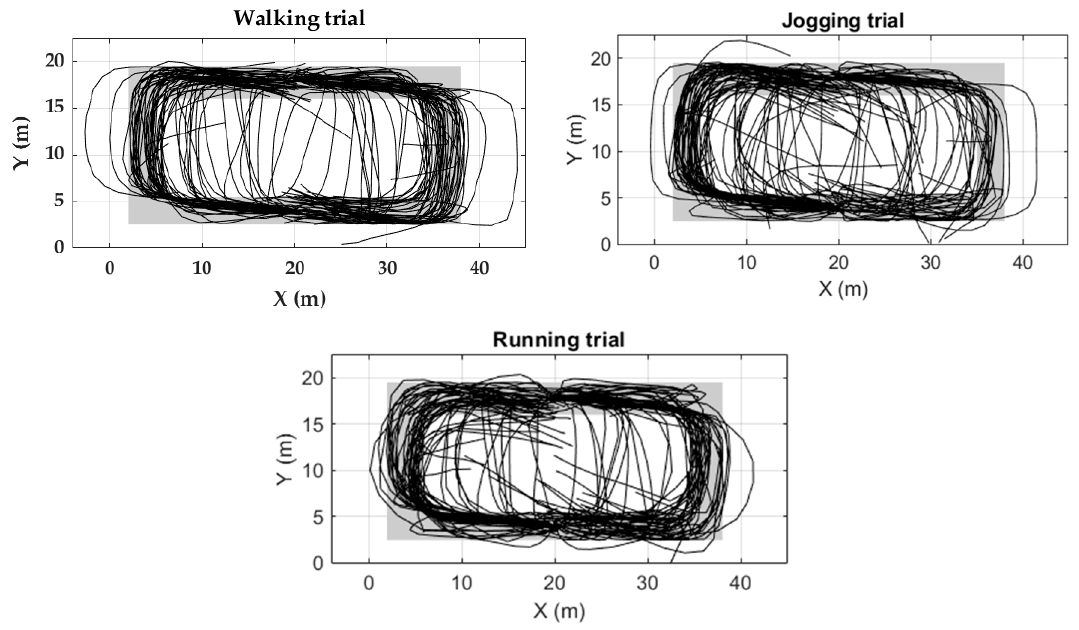
Figure 14. Trajectory reconstruction of circuit activities for all 56 participants of the FAU dataset. Black lines denote the trajectory follows by the participants. Gray zones represent the zone where all the strides should take place.